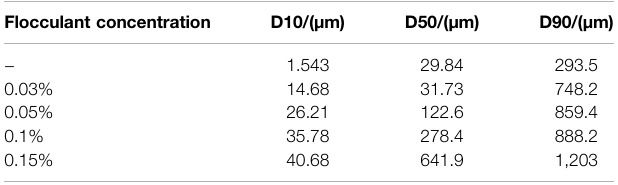
TABLE 10 | Effect of organic fl occulant on particle size distribution of PEM drilling fl uid. Flocculant/(0.05%)